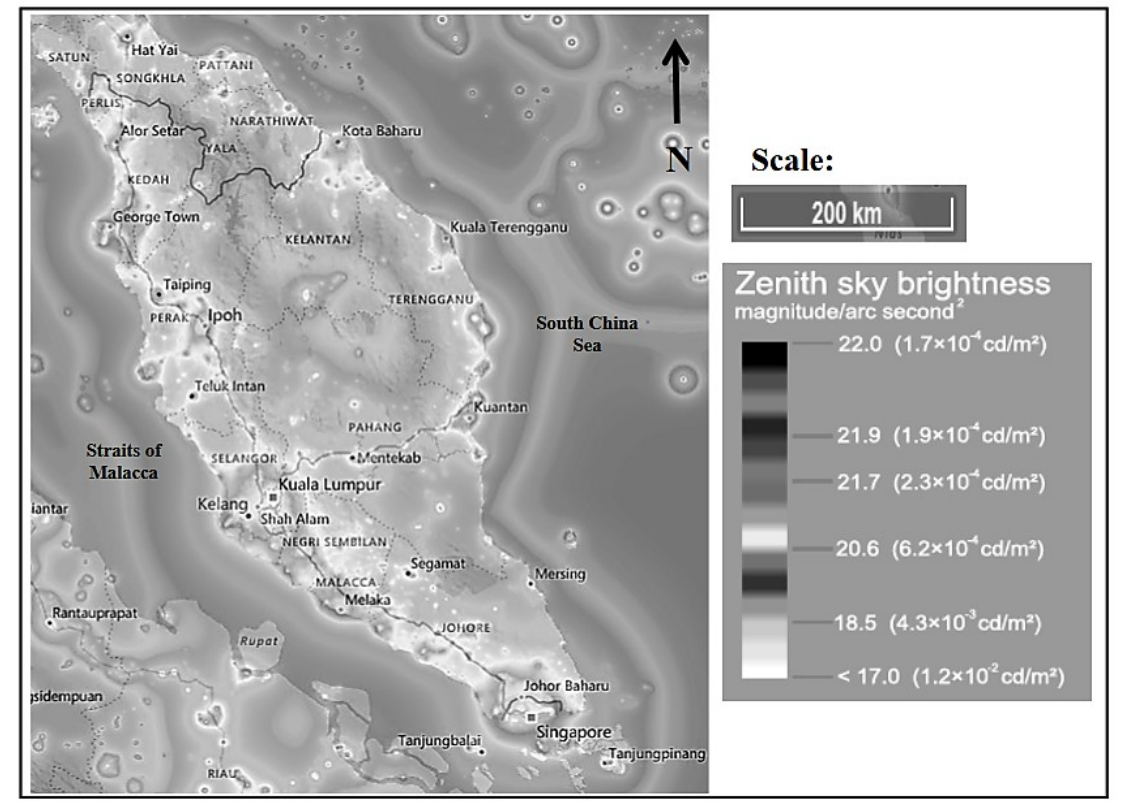
Figure 1. Irradiance map of Peninsular Malaysia [26]. Table 1. Description of the location, population, and brightness of the selected sampling sites.